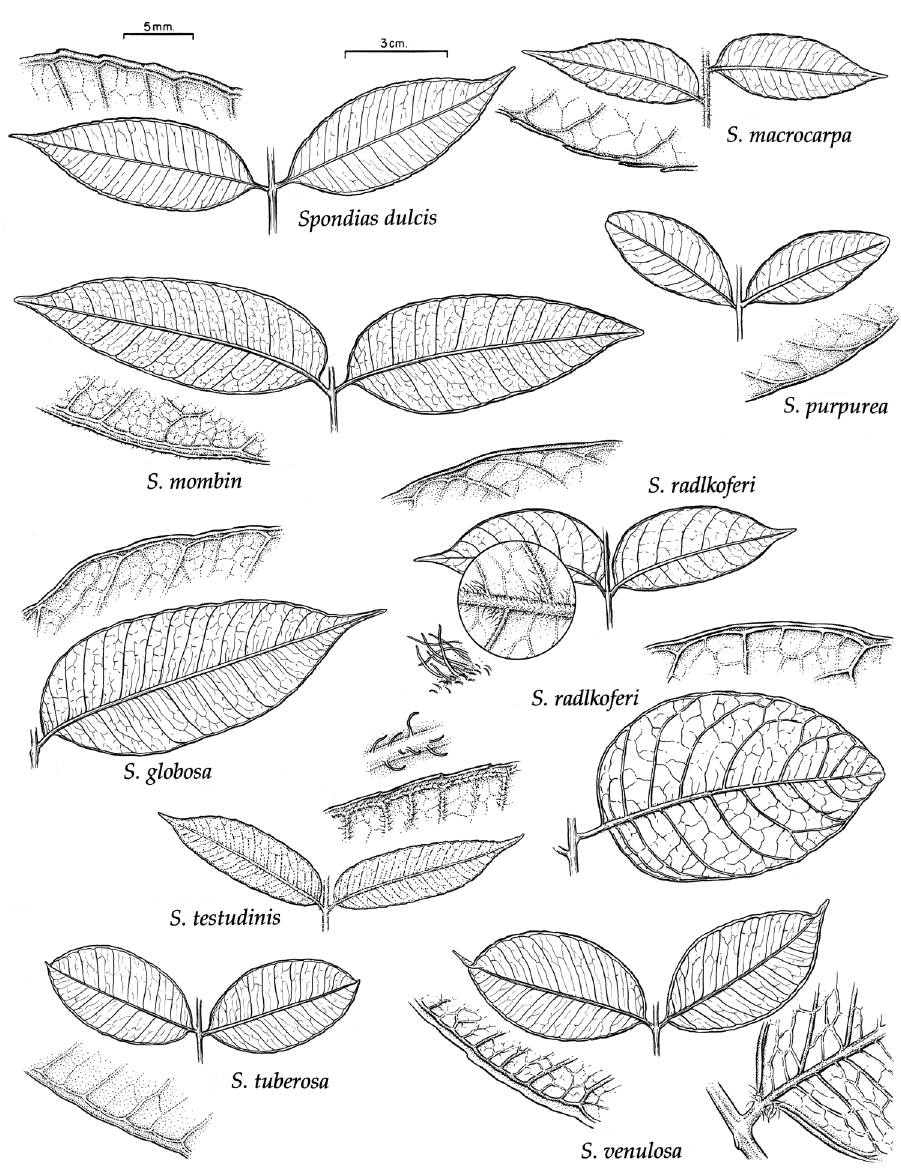
Figure 2. Leaflets of Spondias species, showing details of the margin (insets): Spondias dulcis ( Ayala & Criollo 3982 , NY); S. macrocarpa ( Thomas et al. 6823 , NY); S. mombin ( Acevedo 6037 , NY); S. globosa ( Neill & Palacios 7079 , NY); S. radlkoferi narrow-leaflet form ( Crane 458 , LL) and broad-leaflet form ( Contreras 6976 , LL); S. purpurea ( Grijalva 770 , NY); S. testudinis (Lao Magín 112, NY); S. tuberosa ( Carvalho et al. 3767 , NY); S. venulosa ( Stehmann 20855 ,